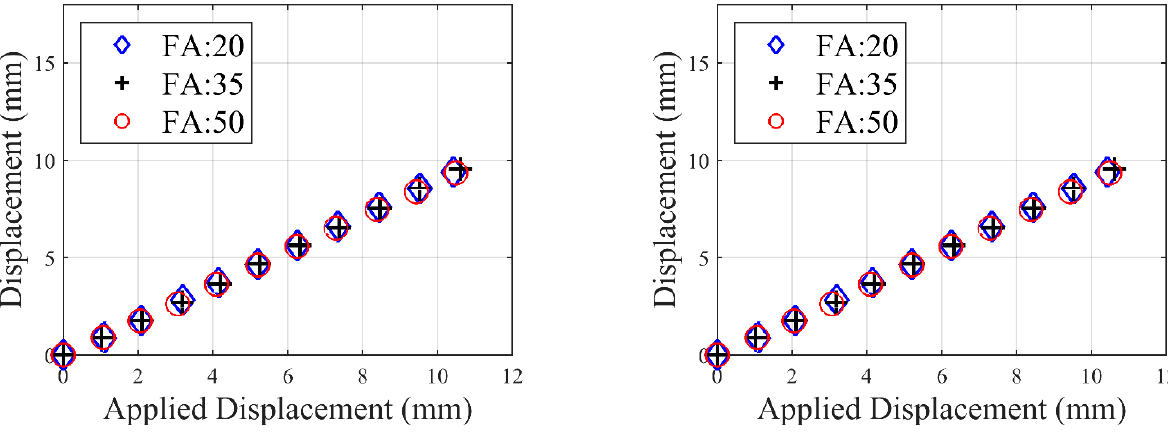
Figure 5. Sensitivity analyses considering the tensile strength and the friction